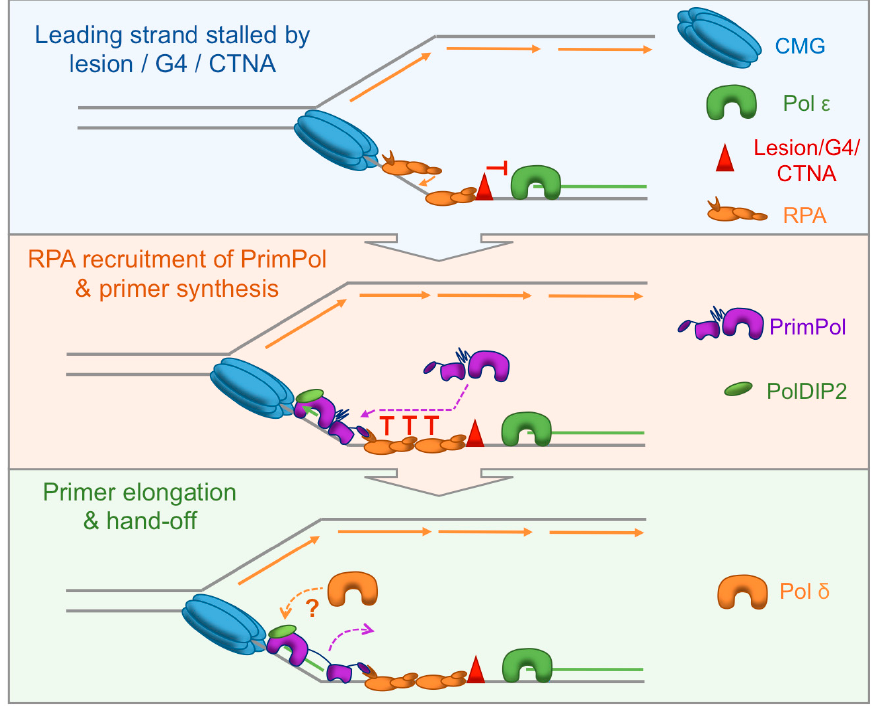
Figure 4. Role, recruitment, and regulation of PrimPol during DNA replication. Top panel: Pol ε is stalled on the leading strand by a lesion, secondary structure, or CTNA. Lagging strand replication continues, subsequently generating ssDNA on the leading strand. This ssDNA is bound by RPA as the CMG complex progresses; Middle panel: The generation of an RPA / ssDNA interface provides a platform for PrimPol recruitment. PrimPol requires a free ssDNA region adjacent to RPA and thus is recruited to the exposed ssDNA behind the CMG complex. This recruitment is facilitated by the interaction between PrimPol’s RBMs and RPA70N. Following recruitment, PrimPol reprimes the leading strand; Bottom panel: PrimPol elongates its primer, assisted by PolDIP2, before further extension is restricted by its ZnF and RPA interaction. The primer is then handed-off to the replicative polymerase, possibly Pol δ , mediated by each protein’s interaction with